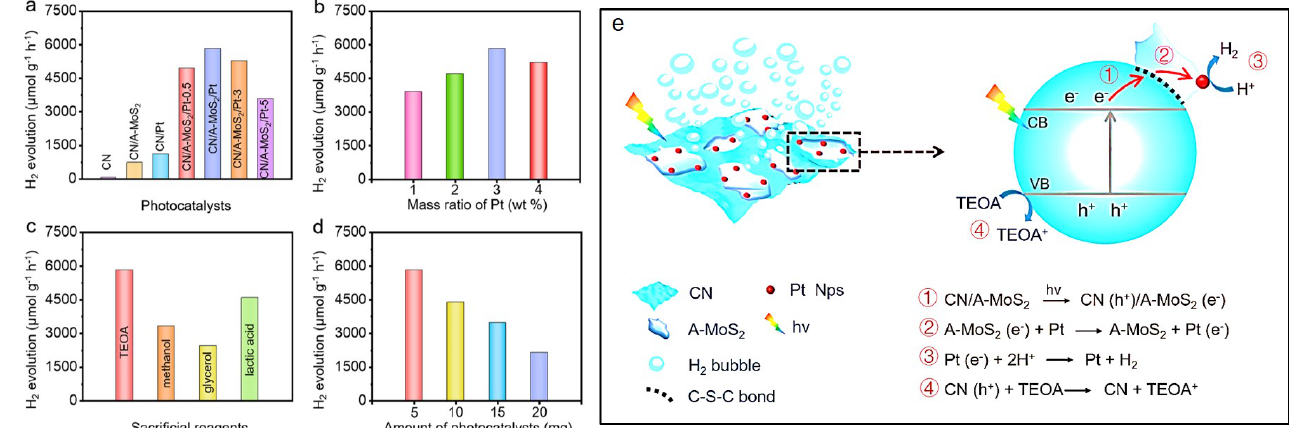
Figure 12. ( a ) Photocatalytic hydrogen production rate of various photocatalysts. ( b ) photocatalytic rate of CN/A-MoS 2 /Pt with different mass ratios of Pt. ( c ) photocatalytic rate of CN/A-MoS 2 /Pt measured in different sacrificial reagents. ( d ) photocatalytic rate of CN/A-MoS 2 /Pt tested with different masses of the photocatalyst. ( e ) Proposed charge transfer mechanism for the CN/A-MoS 2 /Pt photocatalysts [107]. Copyright 2021, American Chemical